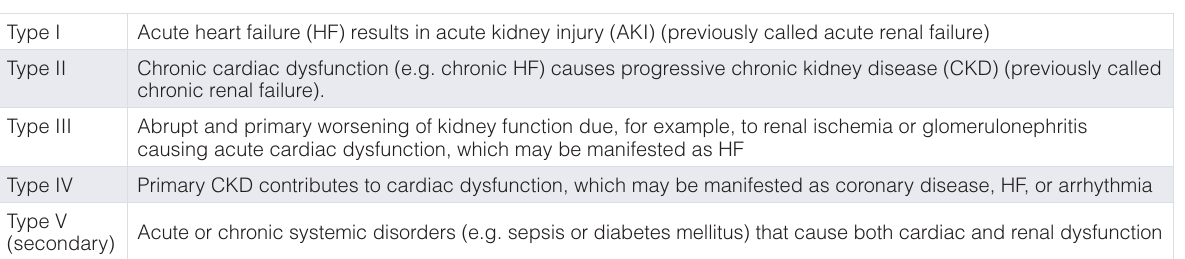
Table 1. Types of cardio-renal syndromes. Type